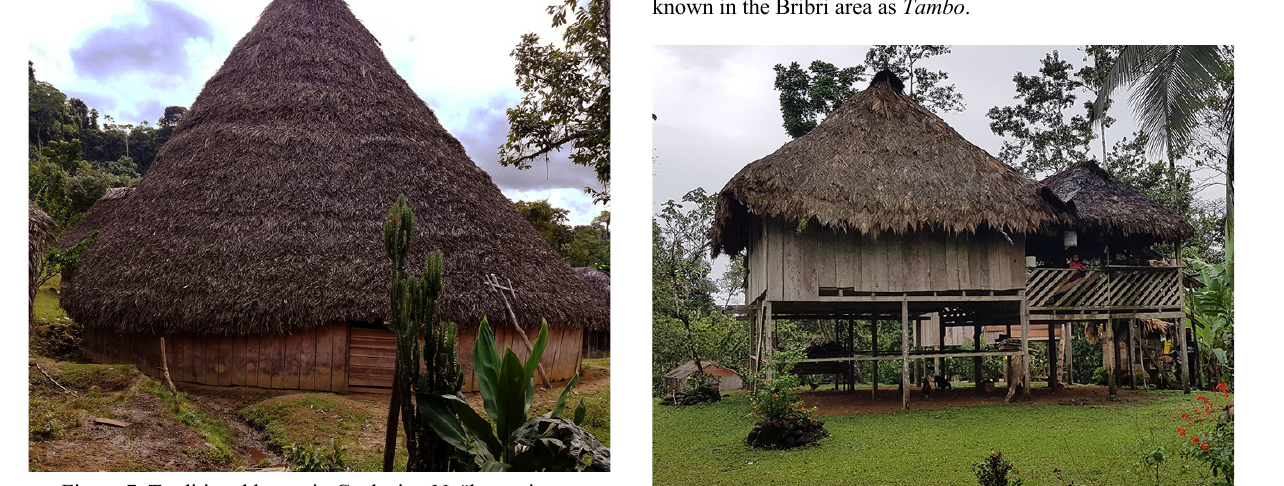
Figure 7. Traditional house in Coclecito, Ngäbe territory.